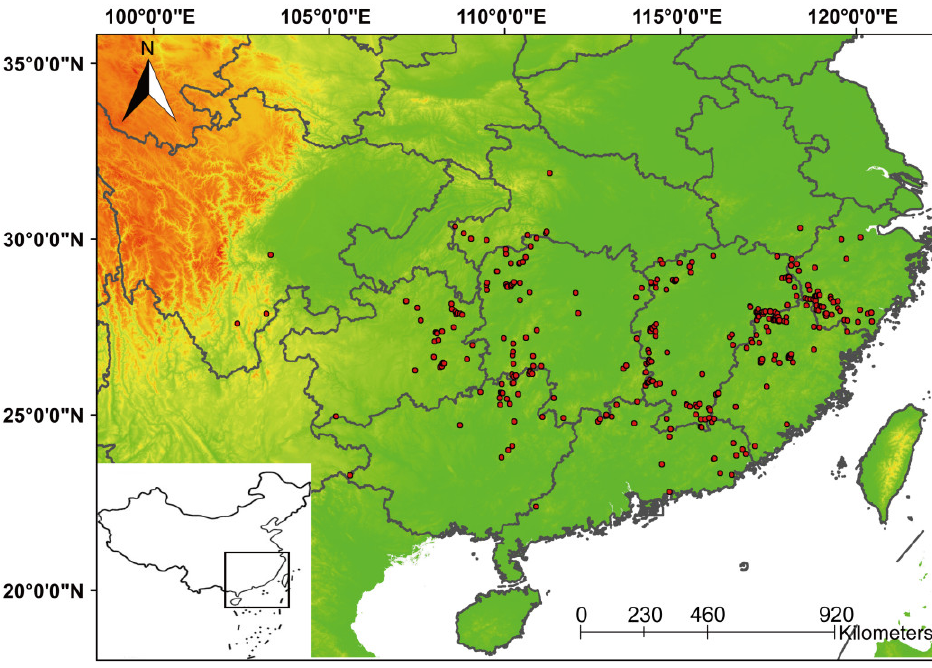
Figure 1. Geographic locations of distribution sites of Acer cordatum Pax in China. The map was quoted from the National Catalogue Service for Geographic Information (www.webmap.cn, accessed on 6 November 2021). Table 1. The contribution of 19 climatic variables to the distribution of Acer cordatum Pax and explanations of each climatic